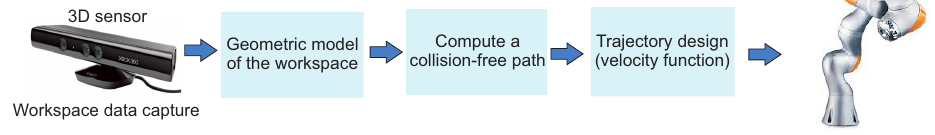
Figure 2. System architecture of an autonomous